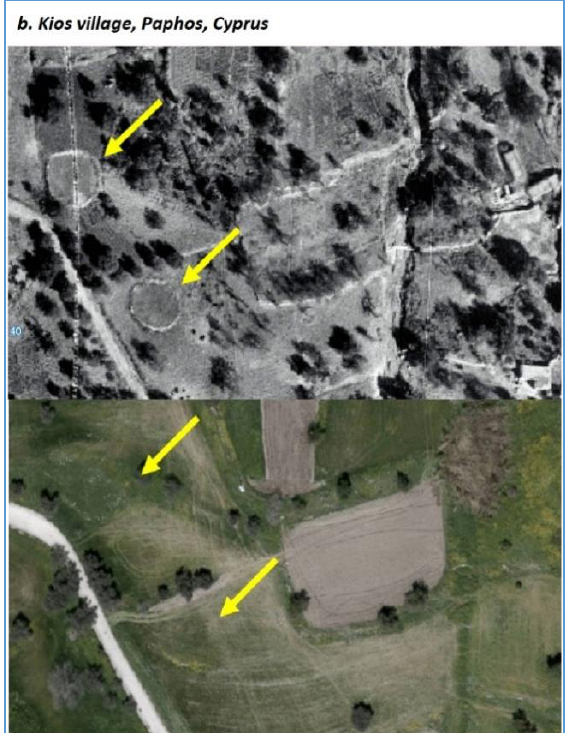
Figure 7. Threshing floors detected in Kios village in 1963. Today these threshing floors are destroyed.